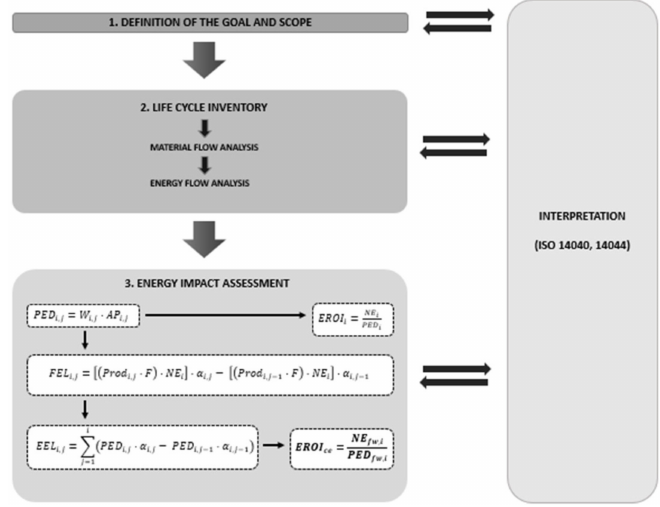
Figure 3. Methodology of the